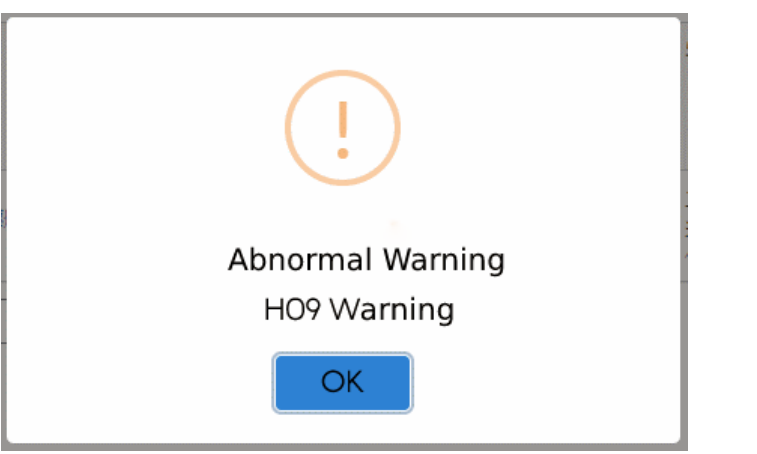
Figure 12. Abnormal